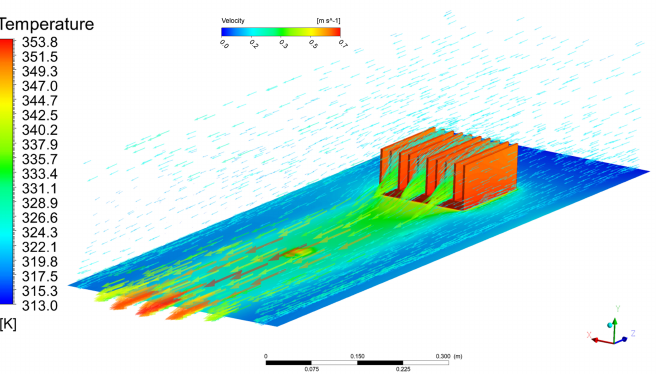
Figure 13. Vector velocity field around the heat sink and temperature distribution of the solid type